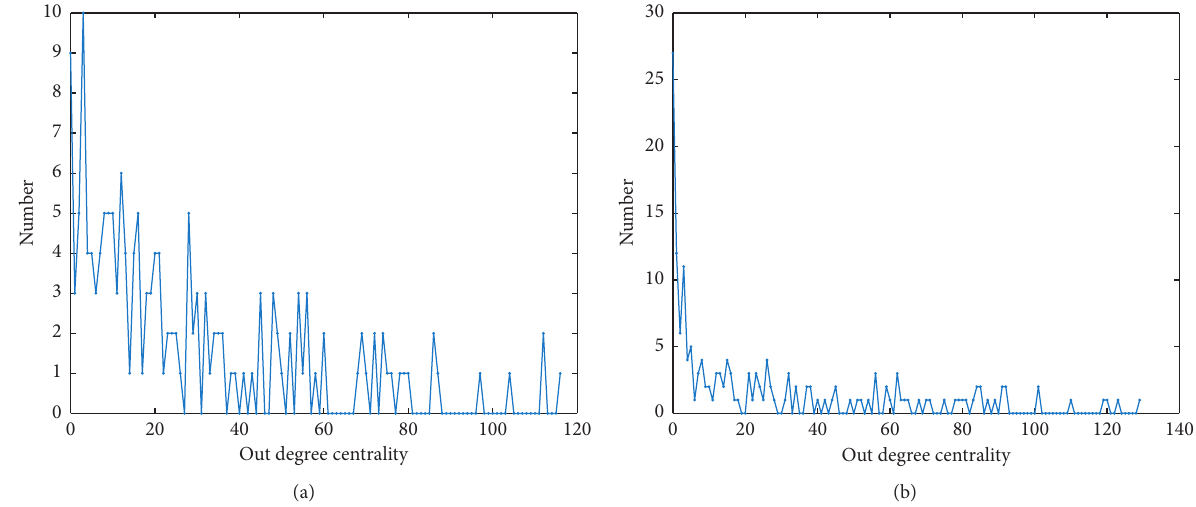
Figure 6: Distribution diagram of out degree centrality of CSI 300 network in 2016-2017 (a) and 2017-2018